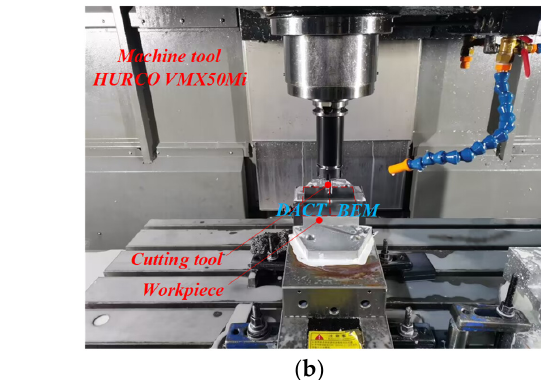
rate was 1500 mm/min . When milling the inclined plane, the path interval was 0.2 mm; when milling the ruled surface, the path interval was 0.1 mm.